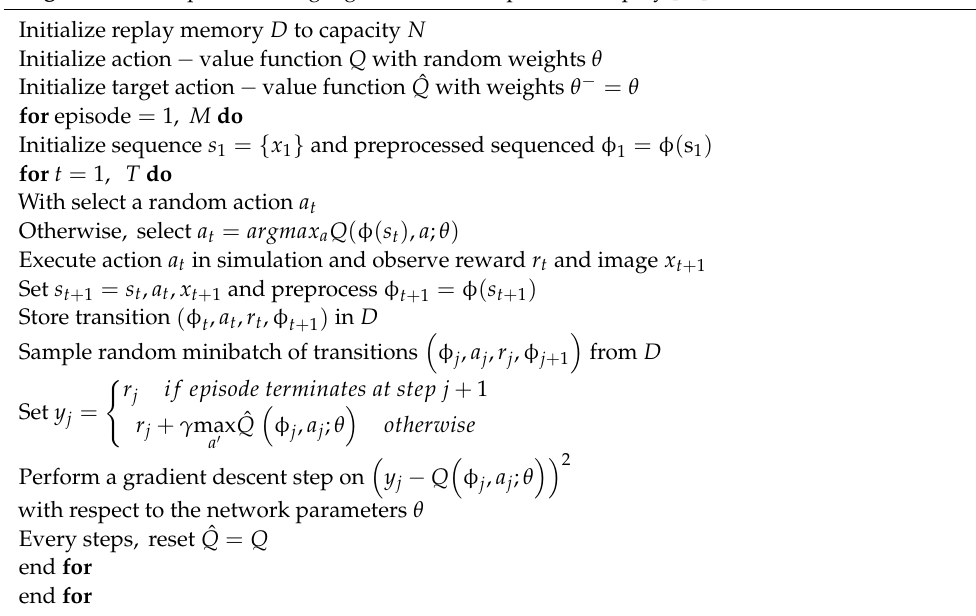
Algorithm 1 Deep Q-Learning algorithm with Experience Replay